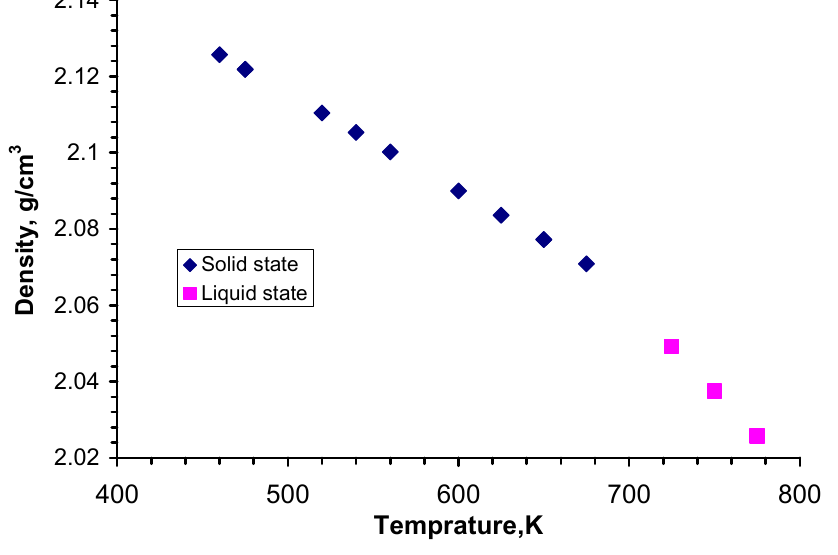
Figure 3. Density of Li 2 BeF 4